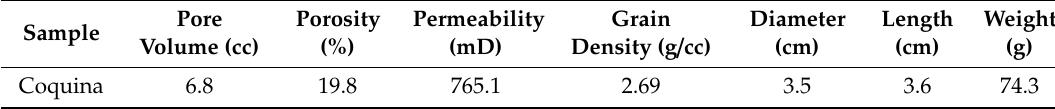
Table 3. Routine petrophysics of the studied coquina sample.